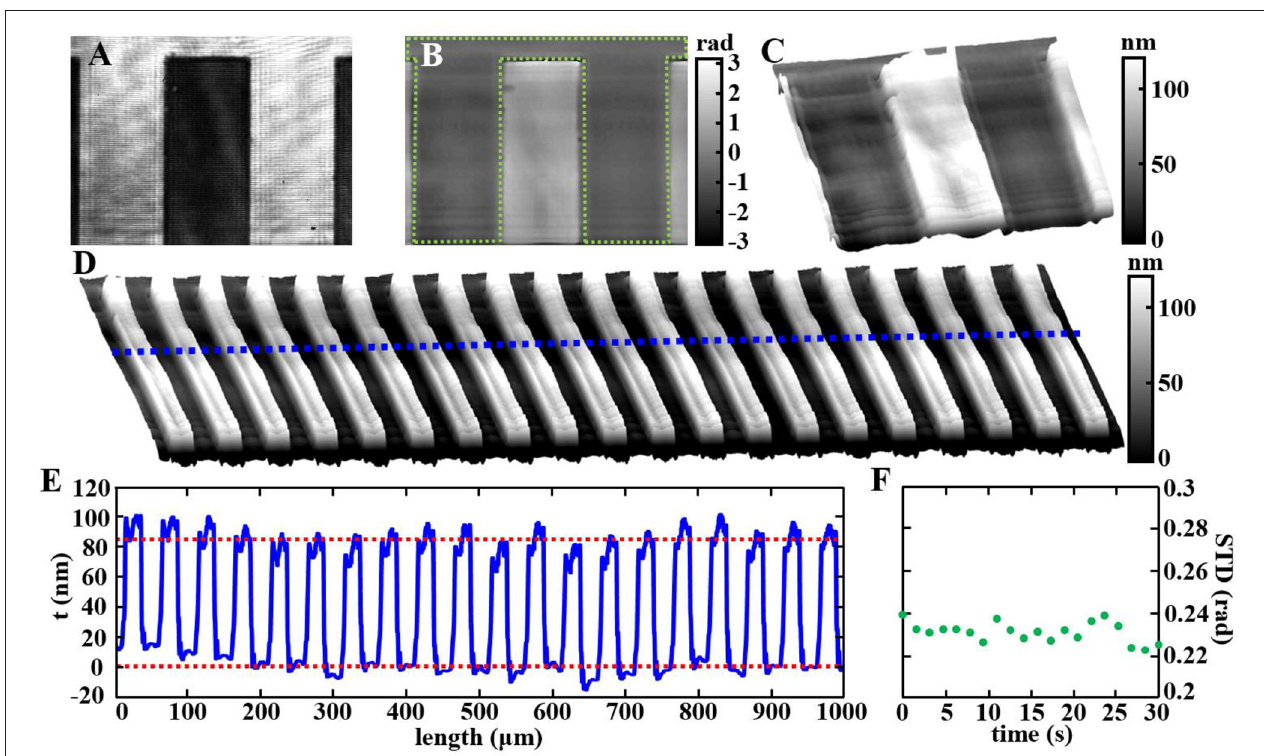
FIGURE 4 | Experimental results of SER-DHM for the case of a 20 lp/mm Ronchi grating. (A) Off-axis digital holograms ( Supplementary Video 1 ). (B) Averaged phase distributions ( Supplementary Video 2 ). (C) 3D thickness distributions ( Supplementary Video 3 ). (D) Total scanned thickness distribution along 20 grating periods. (E) Height profile along blue line included in (D) . (F) STD values of the green region included in (B) before phase